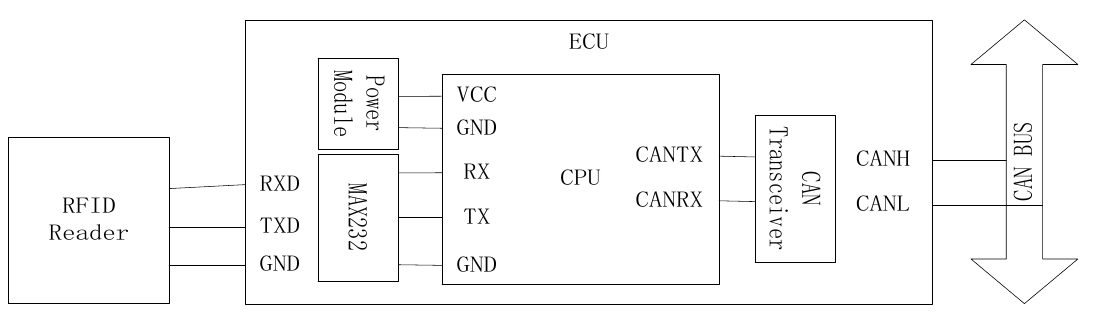
Figure 3. The connection of RFID reader and ECU.